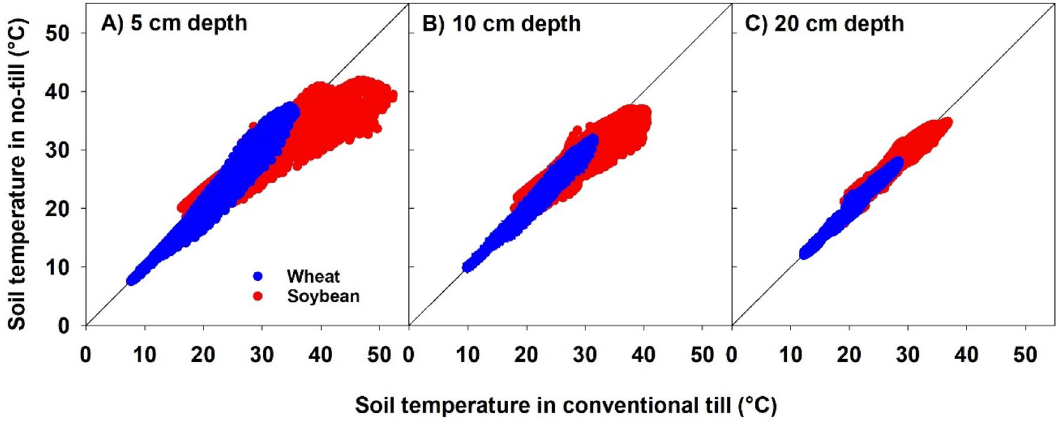
Figure 1. Soil temperature at (A) 5 cm, (B) 10 cm, and (C) 20 cm depths measured at 30-min intervals during the growing season of wheat and soybean under conventional tillage and